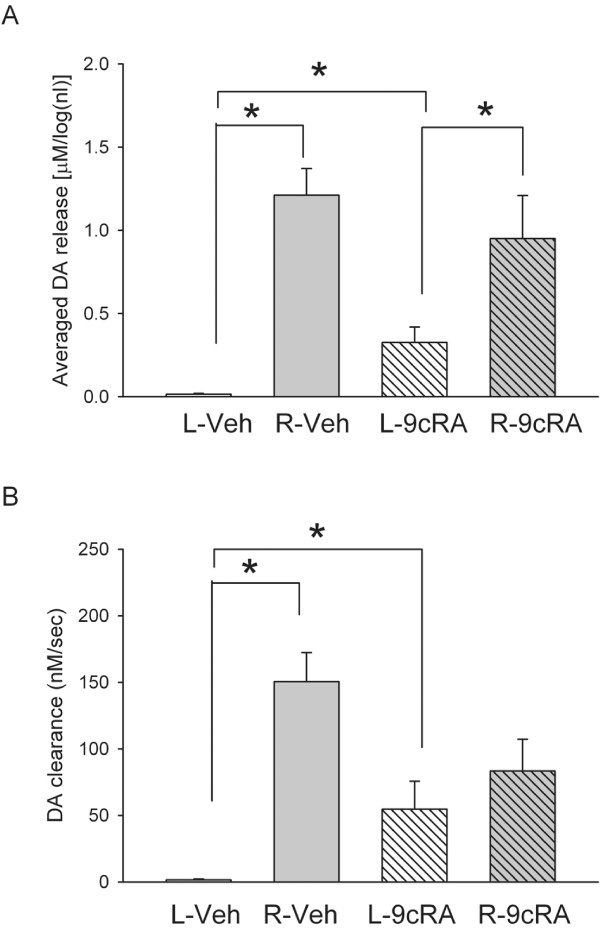
Averaged DA release (A) and rate of DA clearance (B) in striatum in 9cRA or vehicle treated hemiparkinsonian rats. (A) The peak amplitude of the DA signal, induced by local KCl administration, was averaged in lesioned (L, left) or non-lesioned (R, right) striatum of unilaterally 6-OHDA -lesioned rats. KCl-evoked DA release was almost abolished in the L striatum in vehicle treated rats. Treatment with 9cRA significantly increased DA release in the lesioned striatum. (B) The rate of DA clearance (nM/s) after KCl application was calculated between T20 and T60. There is a significant reduction in DA clearance in the striatum ipsilateral to the 6-OHDA lesioning in vehicle treated rats. 9cRA treatment significantly enhanced rate of DA clearance.